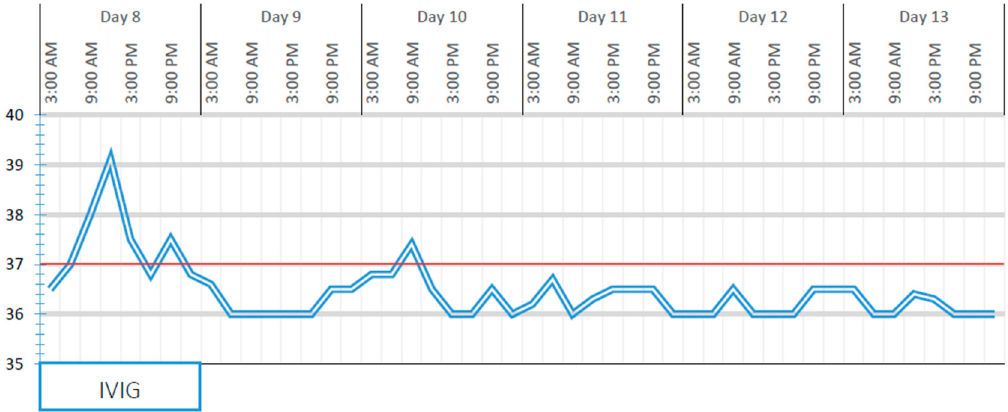
Figure 3. Body temperature from the time of the administration of intravenous immunoglobulin (IVIG) treatment.